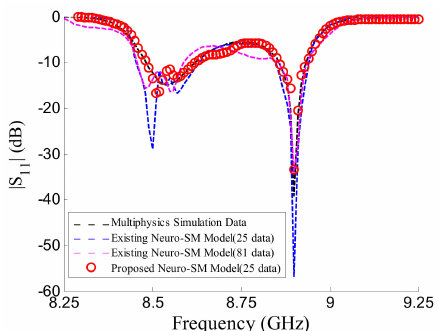
Figure 10. S 11 (in decibels) comparison between the multiphysics simulation data, ANN model (81 data points), existing Neuro-SM model (81 data points) and proposed Neuro-SM model (25 data points) when the test sample is x = [ 3.065,3.14,2.84,2.715,125, − 75 ] T for the iris coupled microwave cavity